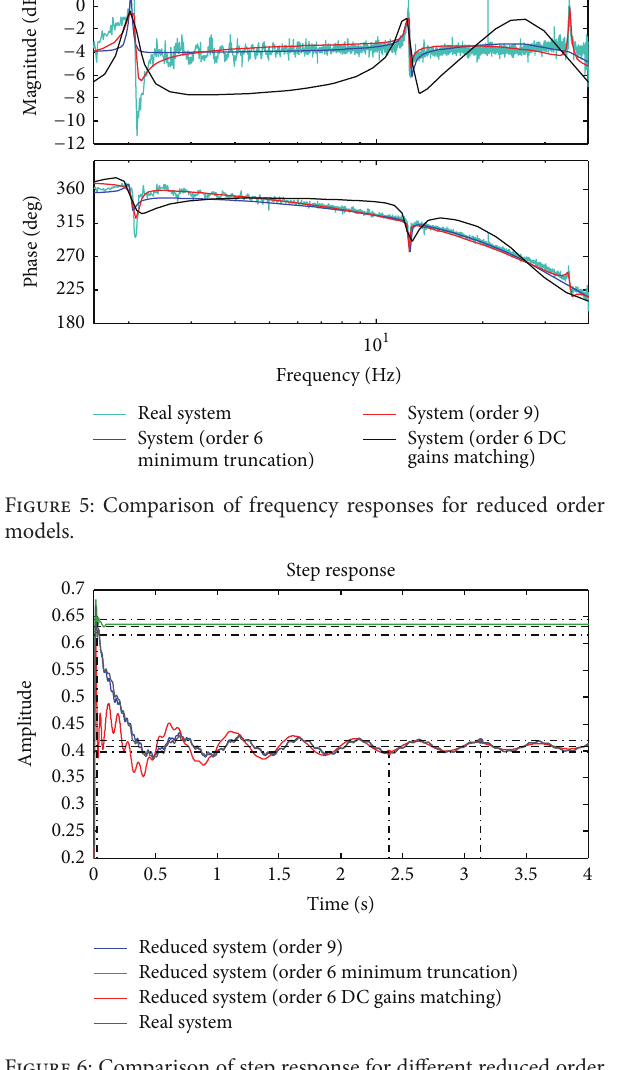
Figure 6: Comparison of step response for different reduced order